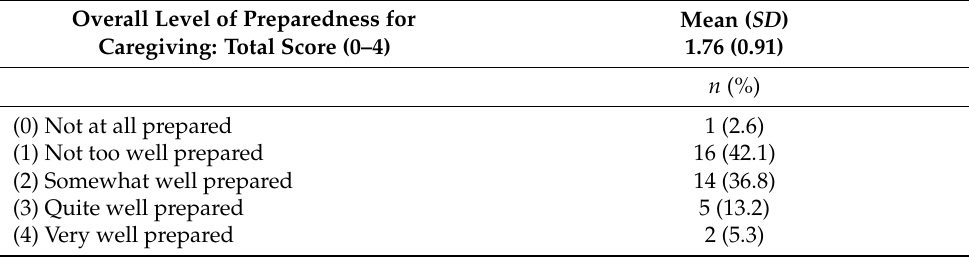
Table 3. Family caregivers’ perceptions of their preparedness for caregiving ( n =